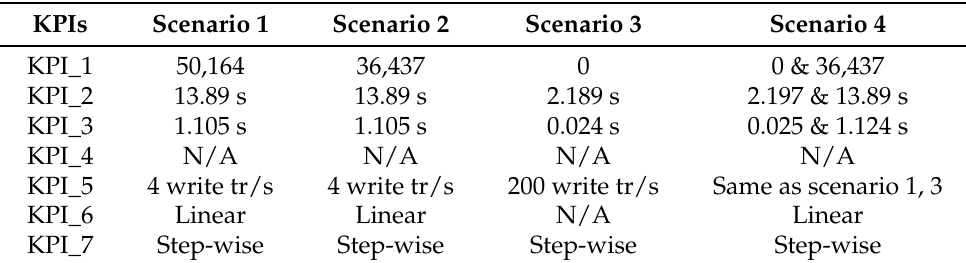
Table 5. System performance evaluation results for all the emulation scenarios. KPIs Scenario